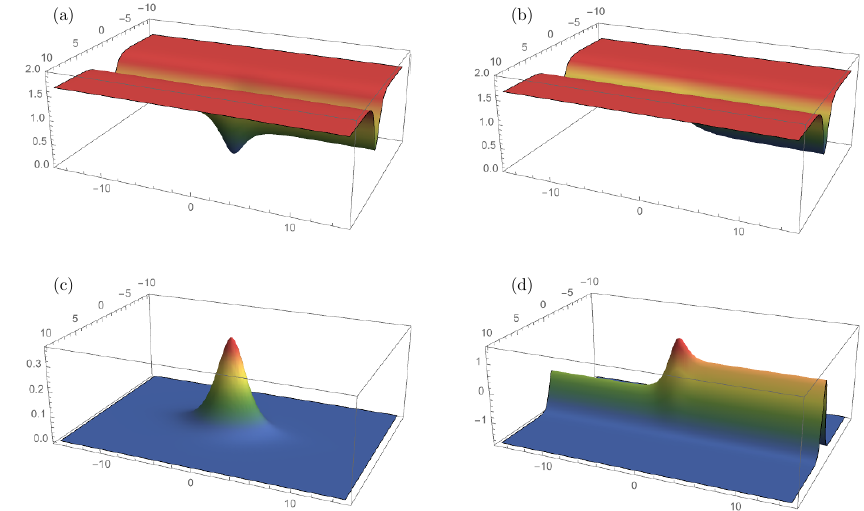
Figure 14 . A snap shot of the (1 ; 0)-string with two domain walls for (cid:24) = (cid:25)= 4 on the plane orthogonal to the string. The panels (a) and (b) show the absolute square of the upper-left (winding) and the lower-right (unwinding) components, respectively. (c) shows the Z -(cid:13)ux and (d) shows the full energy density.